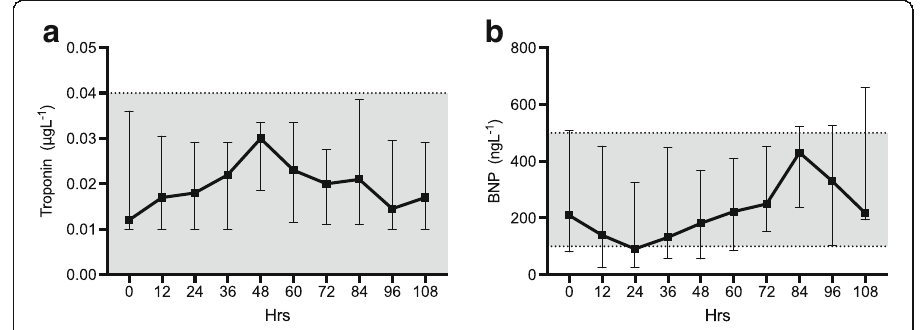
Fig. 3 Cardiac profile. Median and interquartile range for each time point. Normal range is represented by the shaded area. a Troponin I, b β -Natriuretic peptide